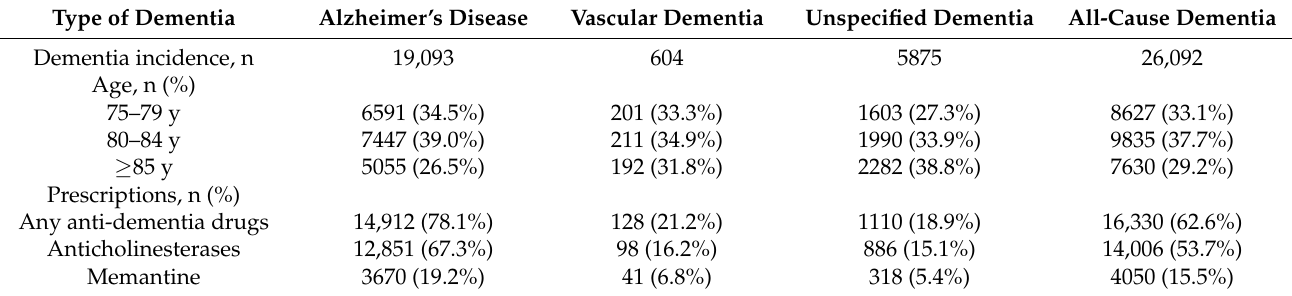
Table 2. Characteristics of incident dementia